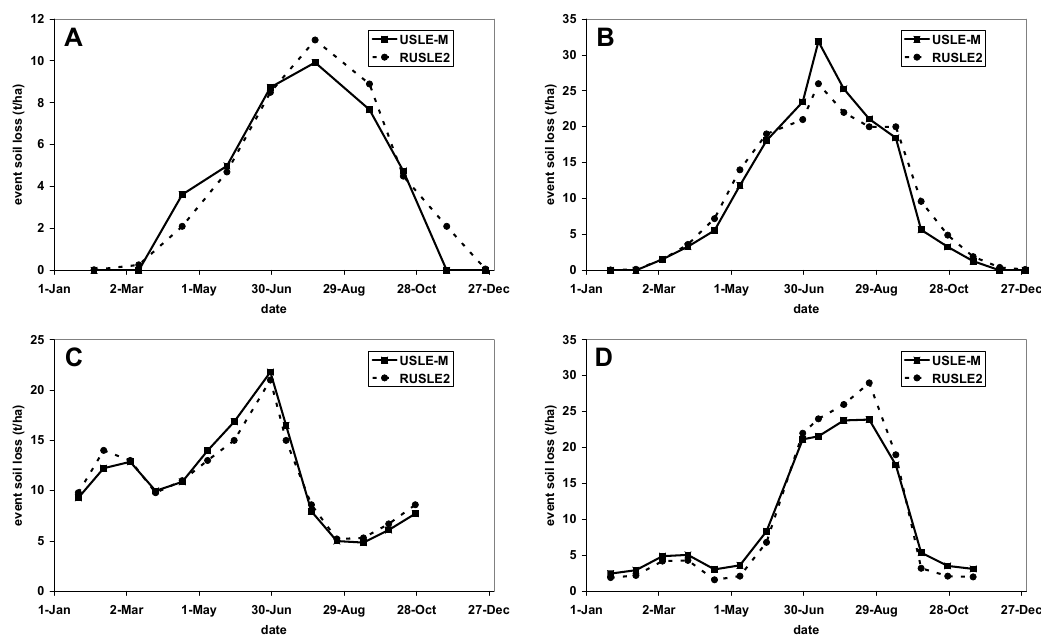
Figure 5. Storm soil losses predicted by RUSLE2 and the Universal Soil Loss Equation (USLE)-M at ( A ) Presque Isle, ME, ( B ) Bethany, MO, ( C ) Macon, GA ( D ) Tampa, FL (source: Kinnell [18]).